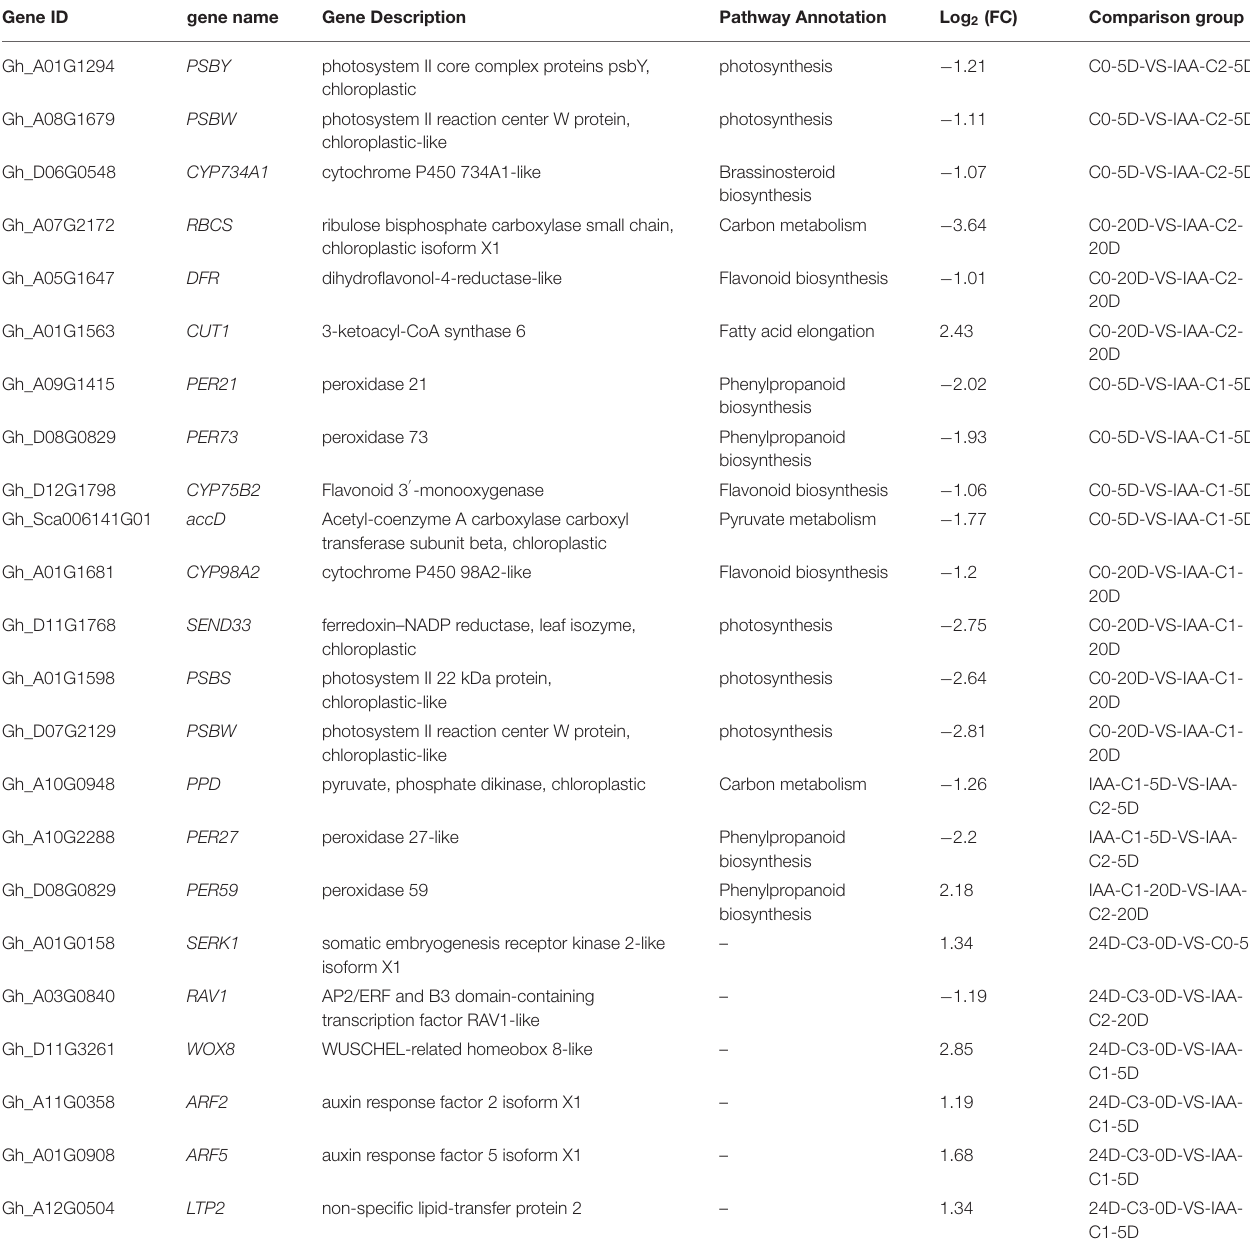
TABLE 3 | Representative DEGs induced by